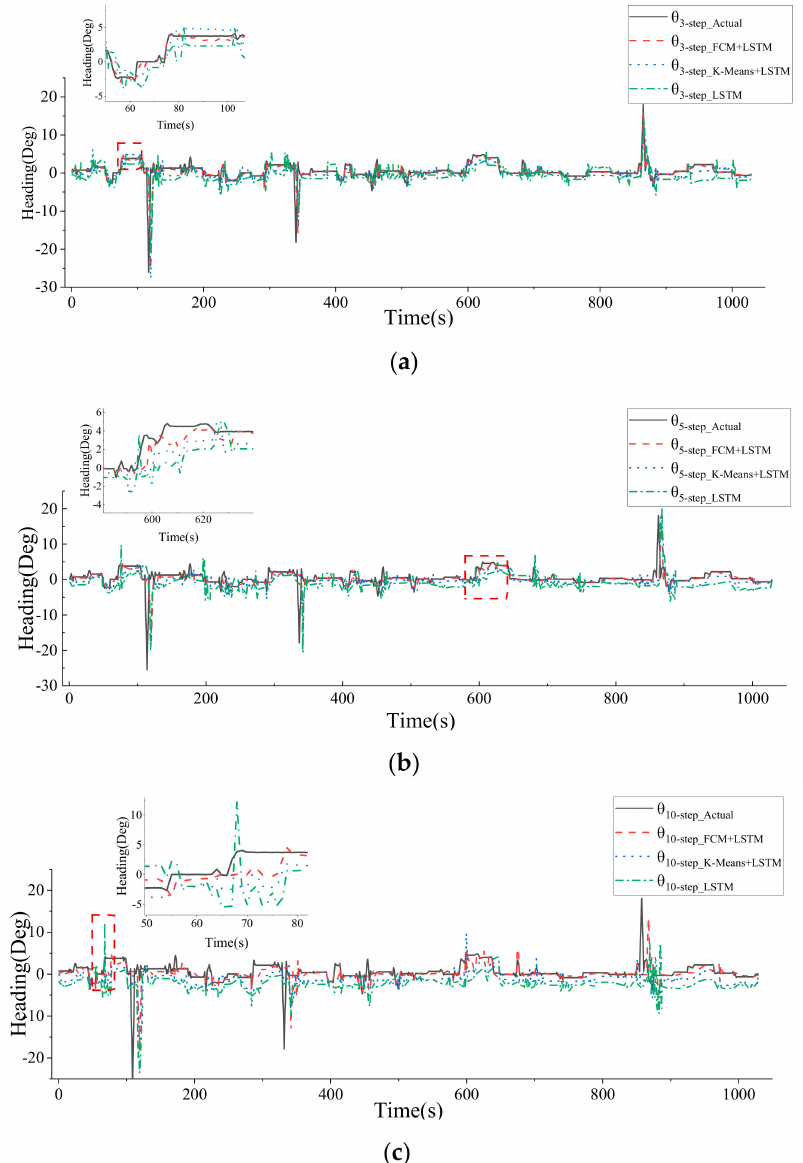
Figure 4. Comparison of multistep heading angle prediction results: ( a ) comparison of the results of 3-step heading angle prediction; ( b ) comparison of the results of 5-step heading angle prediction; ( c ) comparison of the results of 10-step heading angle